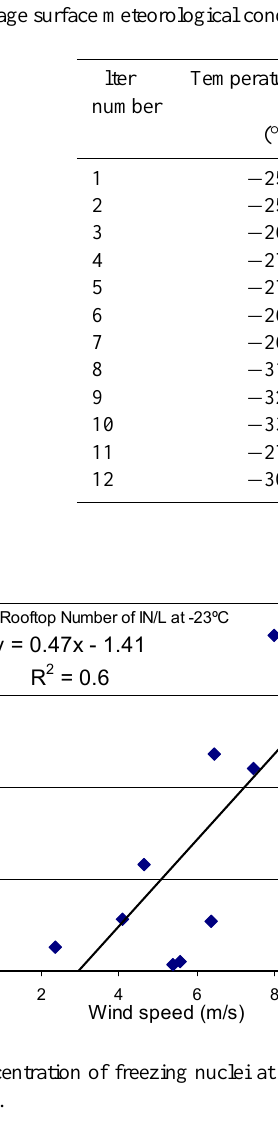
Fig. 7b: Concentration of aerosols > 0.01 μ m as a function of wind speed.